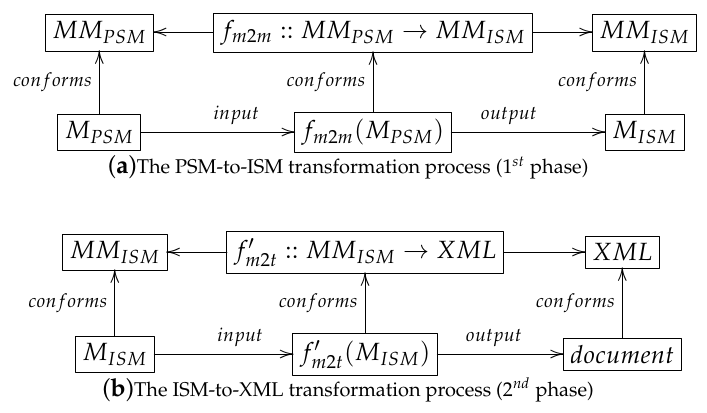
Figure 3. The proposed model-to-text transformation